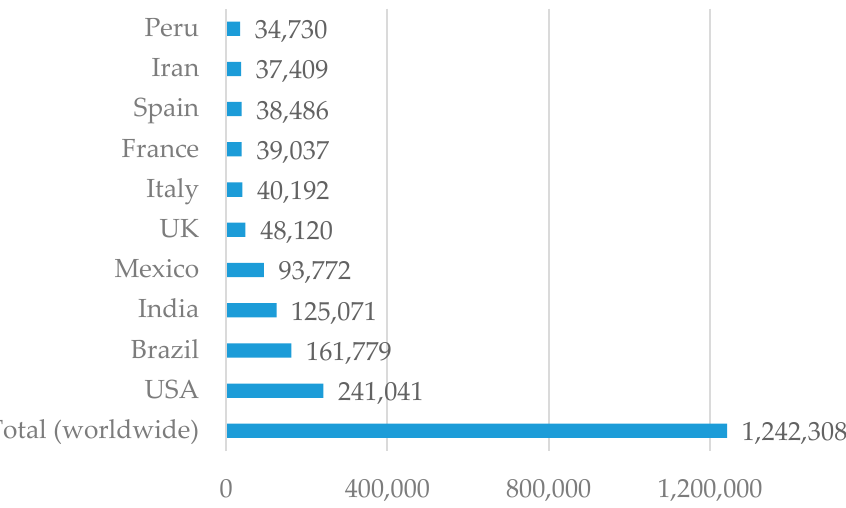
Figure 2. Number of COVID-19 deaths worldwide as of 6 November 2020 by country (top 10 and total worldwide) [10].